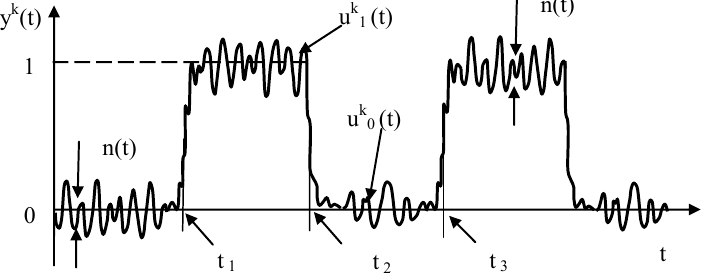
Fig. 3. Basic parameters of the digital signal at the input of the decision-making